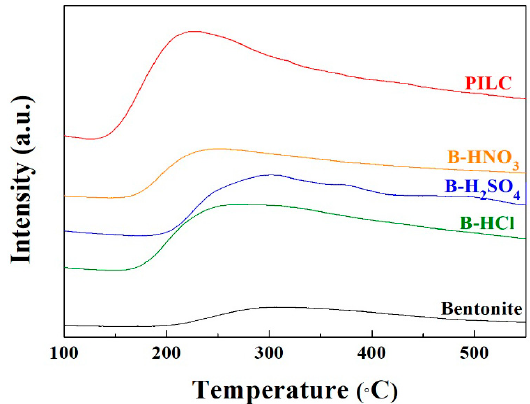
Figure 4. NH 3 -temperature programmed desorption (TPD) of raw bentonite, PILC, B-H 2 SO 4 , B-HNO 3 and